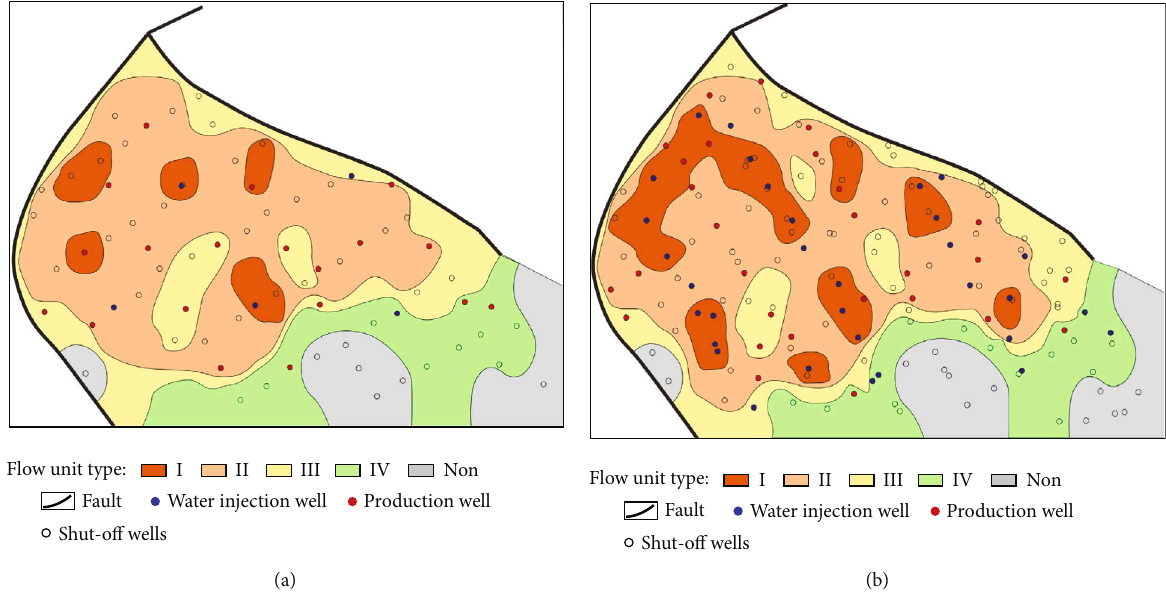
Figure 9: Evaluation diagram of dynamic static-combined fl ow unit on Ng35 fl oor. (a) FZI static fl ow unit layout plan (1983). (b) FZI dynamic fl ow unit layout plan (2021).